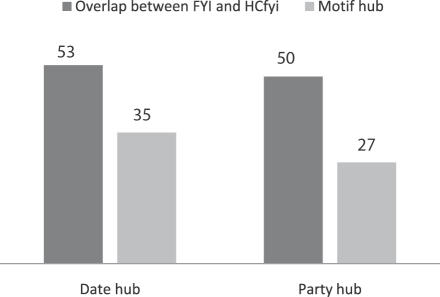
The hub overlap of FYI and HCfyi and the correctly divided mPHs and mDHs in the overlap.